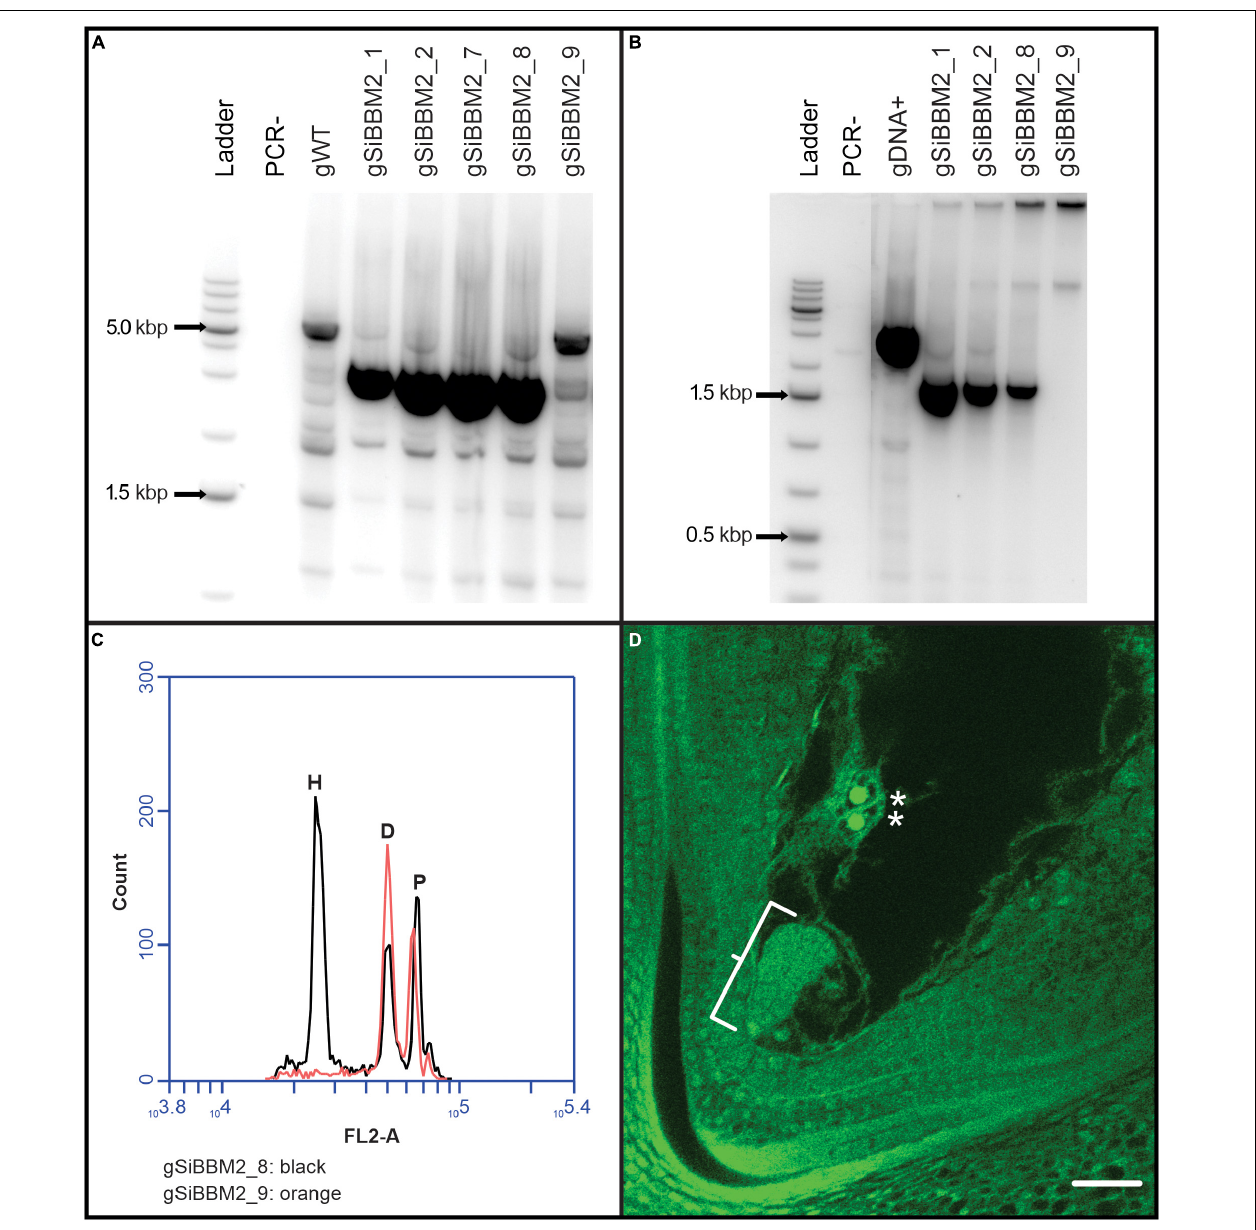
FIGURE 3 | Overview of transgenic T 0 line evaluation. Analysis of gSiBBM2 lines (A–D) . (A) PCR products from transgenic lines, most showing the expected size of the full length g SiBBM 2 transgene. gSiBBM2_9 , while positive for the hygromycin plant selectable marker, did not contain a full-length gSiBBM2 transgene. The PCR- lane is a negative control with no DNA added to the PCR reaction tube while the gWT lane is DNA isolated from an untransformed wild-type Oryza sativa Nipponbare plant. (B) Non-quantitative RT-PCR expression of the gSiBBM2 transgene in ovary tissue collected prior to fertilization. (C) Bulk seed flow cytometry results as an overlay from two samples of gSiBBM2 lines, one with (black) and without (red) the gSiBBM2 transgene. The H peak corresponds to rice embryo haploid (N) signal, the D peak corresponds to the rice embryo diploid (2C) signal, and the P peak corresponds to the genome standard P. notum diploid (2C) signal. (D) Confocal image of a parthenogenic embryo in rice induced by the gSiBBM2 transgene. The parthenogenetic embryo is shown in the bracket, while the presence of unfused polar nuclei (starred) denotes that fertilization has not occurred. The scale bar equals 25 µ m.